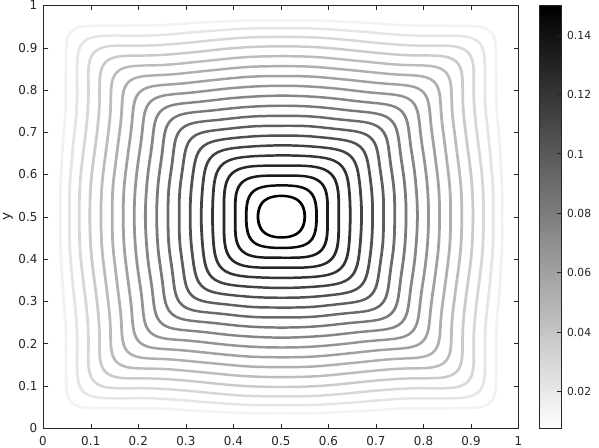
Figure 7: Approximated Optimal Control Figure 8. Compliance along the iteration process. Figure 8: Compliance along the iteration process